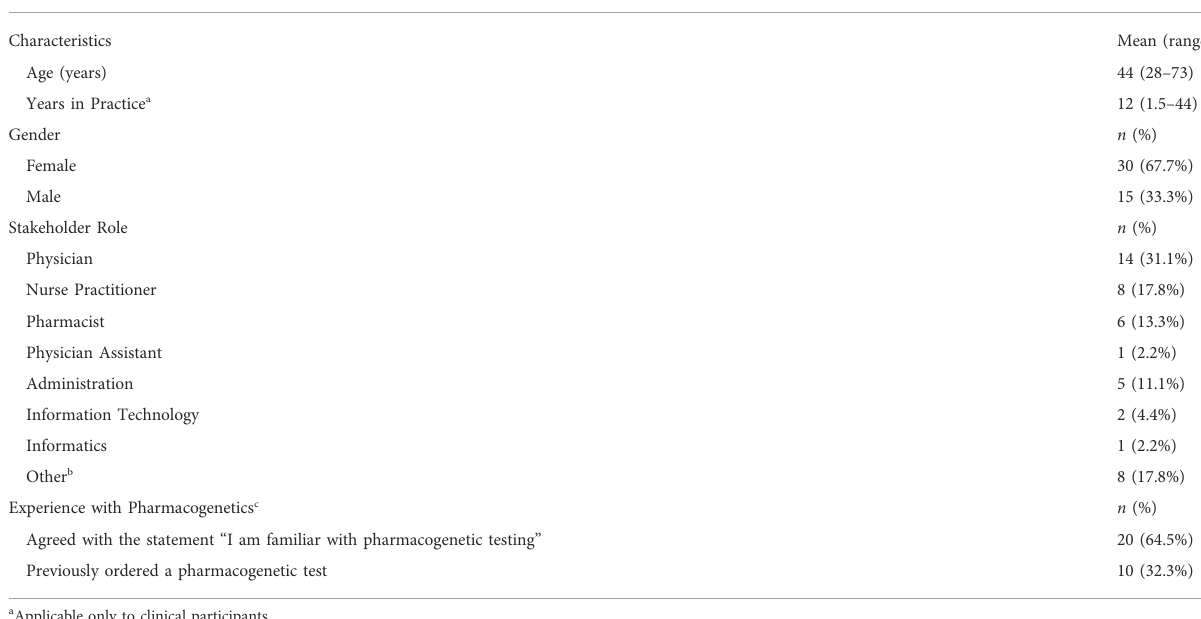
TABLE 2 Participant demographics ( n = 45).